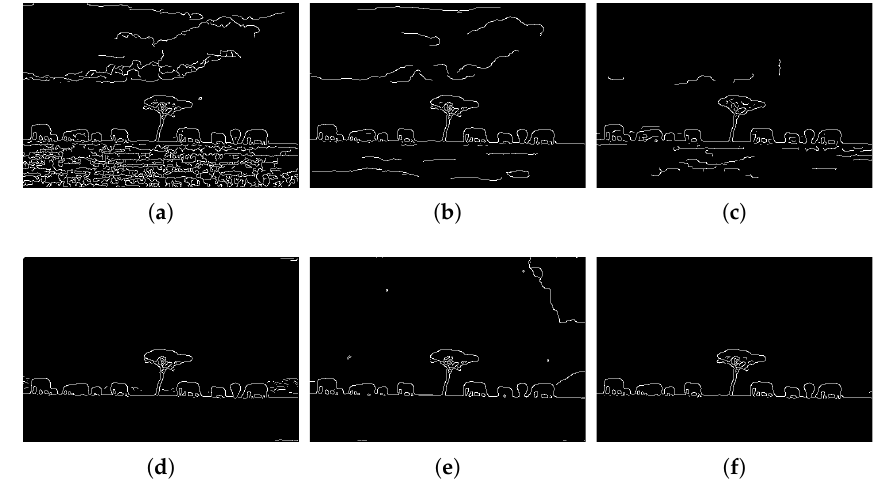
Figure 7. Applying Canny edge detector to the grayscale version of Figure 6. ( a ) Input; ( b ) Bilateral [18]; ( c ) WLS [21]; ( d ) l 0 -smoothing [24]; ( e ) l 0 -projection [29]; ( f )